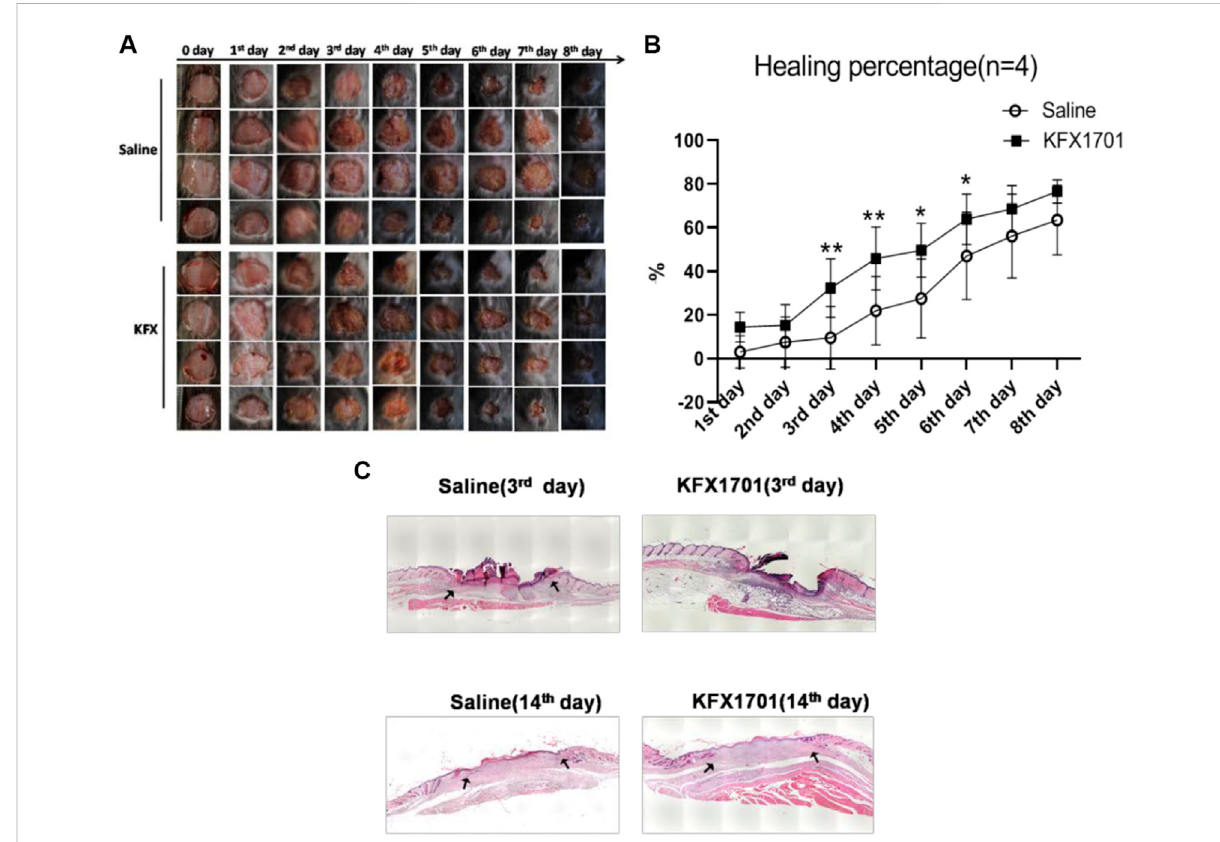
FIGURE 3 In vivo wound-healing effect of Kangfuxin in a cutaneous-perforation wound-healing animal model. (A) Photographs of wounds taken 0 – 8 days after cutaneous-perforation wounding in the saline and KFX groups. Scale bar = 5 mm. (B) Wound healing is indicated by the reduction in percentage of the initial wound area at 1 – 8 days after cutaneous-perforation wounding. Data are shown as mean ± SD values. * p < 0.05, ** p < 0.01, *** p < 0.001 vs. the control group. NS, not signi fi cant. (C) , H&E staining of cutaneous-wound tissues in KFX group and saline